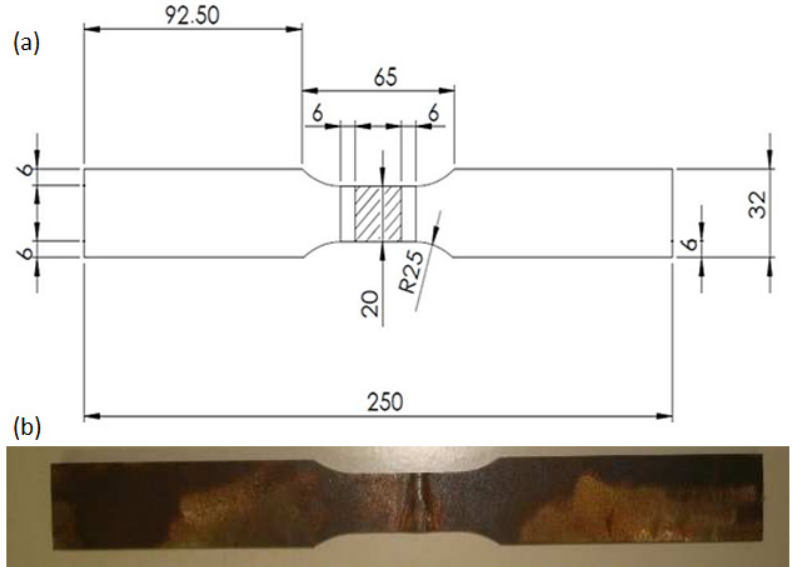
Figure 3. Tensile test specimens: ( a ) schematic with dimensions (mm), and ( b ) actually tested specimen with rupture beginning at the HAZ.